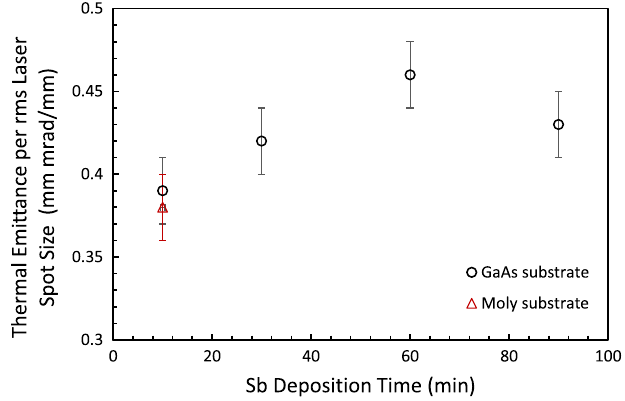
FIG. 9. Thermal emittance per rms laser spot size versus Sb deposition time with the smallest values obtained for the shortest Sb deposition time.